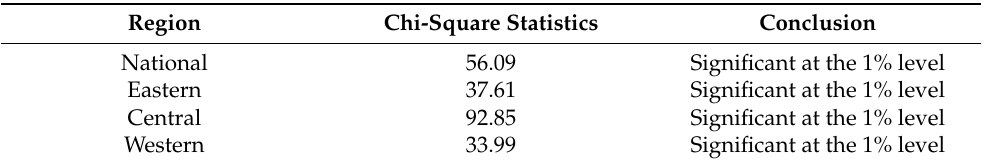
Table 2. Hausman test results.